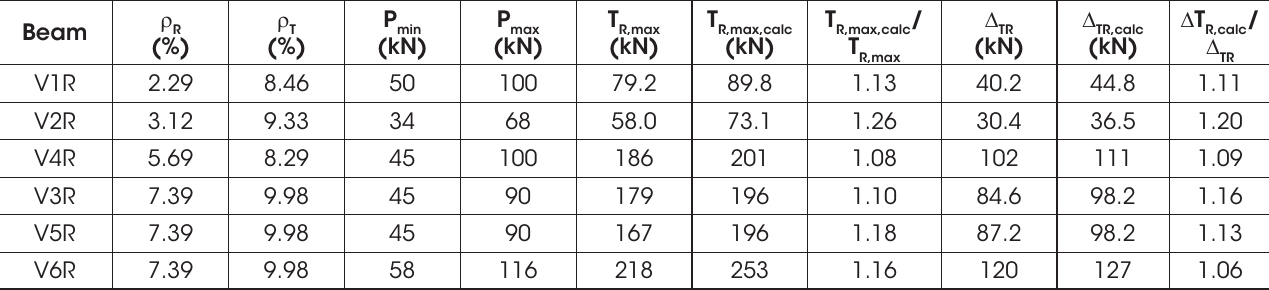
Jacket main steel maximum force T measured and calculated steel strains